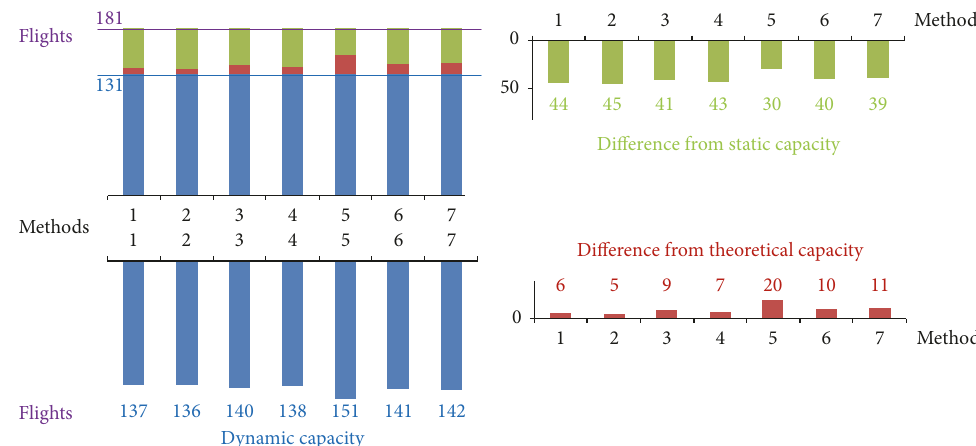
Figure 12: Load distributions of the sectors under the seven alternative flight paths.